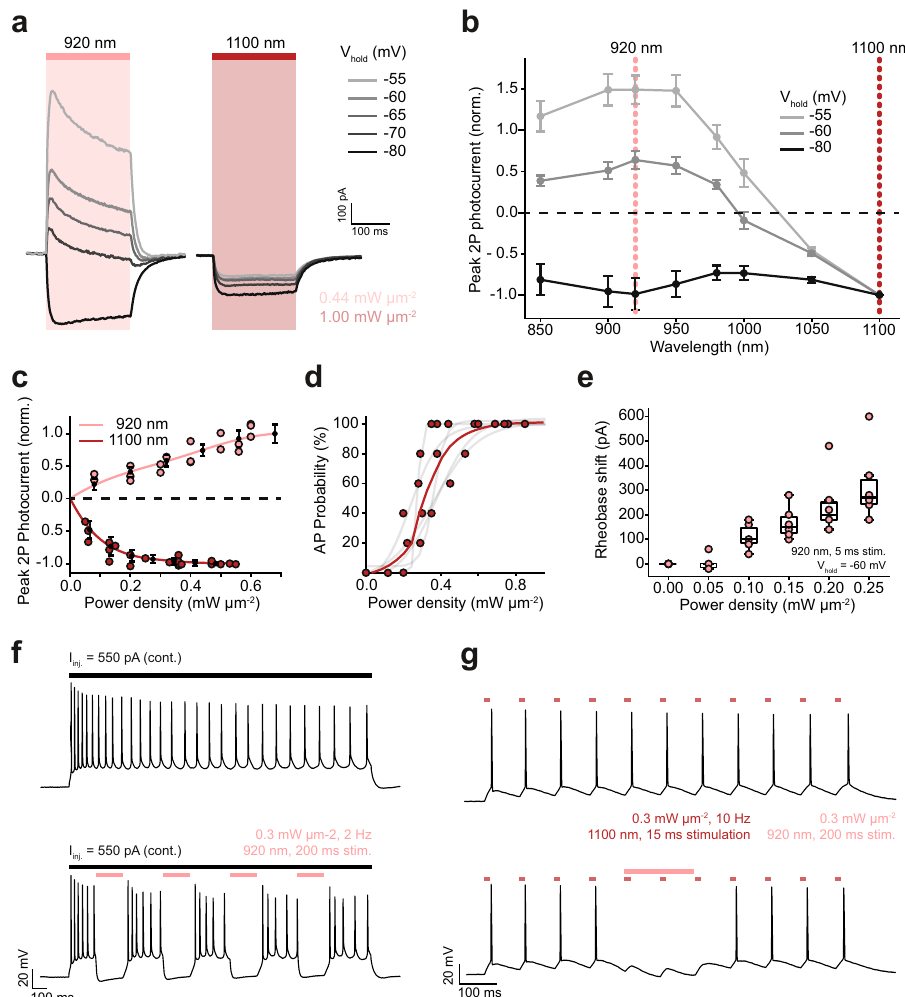
Fig. 5 Bidirectional control of neuronal activity with somBiPOLES using dual-color two-photon holography. a – c Voltage clamp (VC) characterization of somBiPOLES in CA1 pyramidal cells. a Representative photocurrent traces at different holding potentials, obtained by continuous 200 ms illumination of 920 and 1100 nm at constant average power density (0.44 and 1.00 mW µ m − 2 ). b Peak photocurrent as a function of wavelength at different holding potentials (mean ± SEM, n = 5). Data acquired with a constant photon fl ux of 6.77 × 10 26 photons s 1 m − 2 . Dashed lines indicate 920 and 1100 nm respectively; the wavelengths subsequently utilized for photo-stimulation and inhibition. c Peak photocurrent as a function of incident power density at a holding potential of − 60 mV (mean ± SEM, 920 nm, n = 4; 1100 nm, n = 5). d – g Current clamp (IC) characterization of somBiPOLES in CA1 pyramidal cells. d Probability of photo evoked action potentials under 1100 nm illumination for 5 ms ( n = 5, red: average, gray: individual trials). e Characterization of the ef fi cacy of silencing somBiPOLES expressing neurons under 920-nm illumination by co-injection of current (Box: median, 1st – 3rd quartile, whiskers: 1.5x inter quartile range, n = 5). f Representative voltage traces demonstrating sustained neuronal silencing of neurons by two-photon excitation of somBiPOLES at 920 nm. Upper trace (control): 550 pA current injected (illustrated by the black line), no light. Lower trace: continuous injection of 550 pA current, 0.3 mW µ m − ², 920 nm, 2 Hz, 200 ms illumination. g Two-photon, bidirectional, control of single neurons demonstrated by co-incident